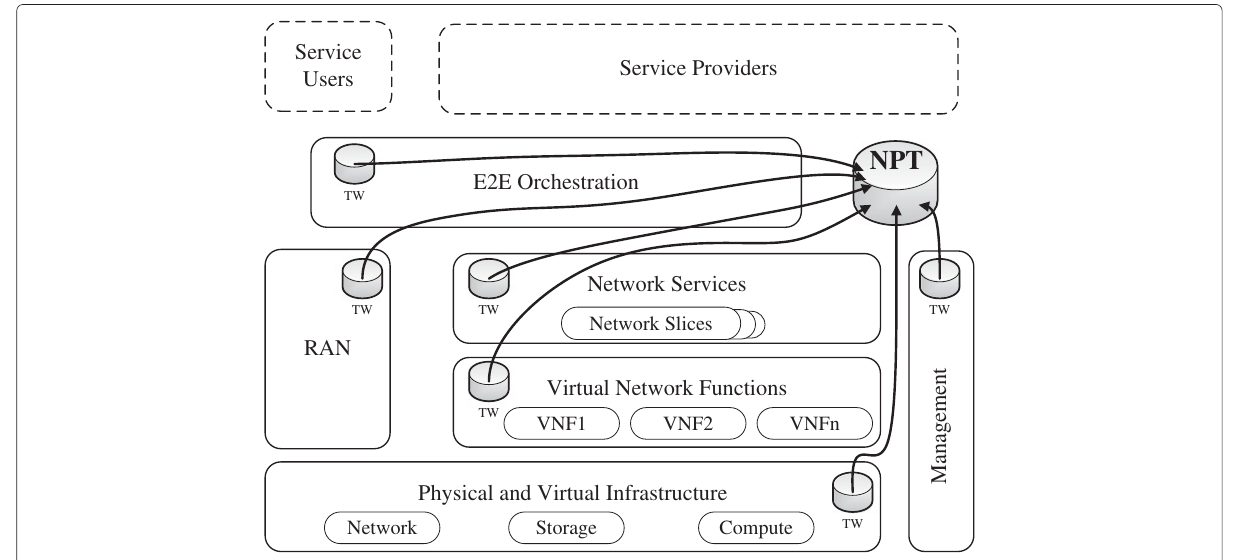
Fig. 10 NPT system within 5G ecosystem: logical